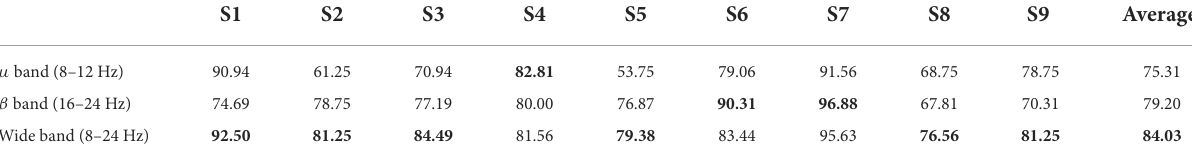
TABLE 8 The LDA model performance of clustered feature based on different frequency band in griping vs. opening